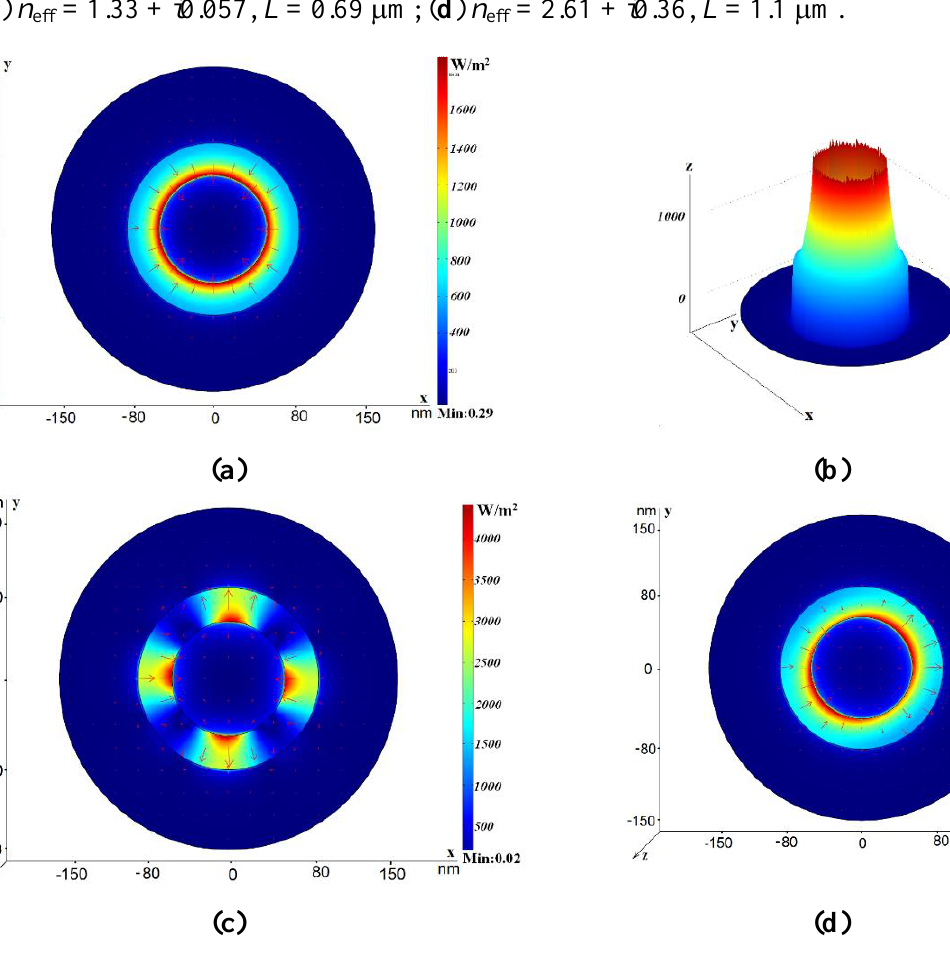
= 50 nm, silver rod = 3.027+ i 0.037, eff